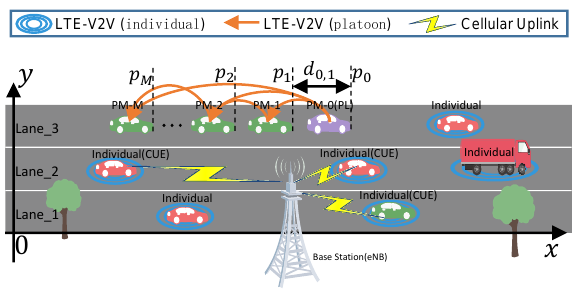
Figure 1. Platoon and individual vehicles driving